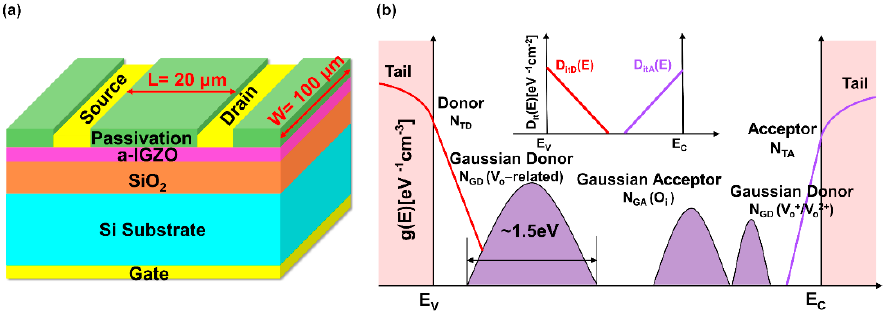
Figure 1. ( a ) Schematic diagram of the a-IGZO TFT with a bottom-gate structure; ( b ) Schematic il- lustration of the DOS model in the a-IGZO TFTs. The N TD and N TA represent the donor-like and acceptor-like tail states, respectively. The three gaussian curves represent the deep V o -related states ( N GD (V o -related) ), oxygen interstitials ( N GA (O i ) ), and shallow donor states ( N GD (V o+ /V o2+ ) ), respectively. The inset is the schematic illustration of the interface trap density ( D it (E) ).